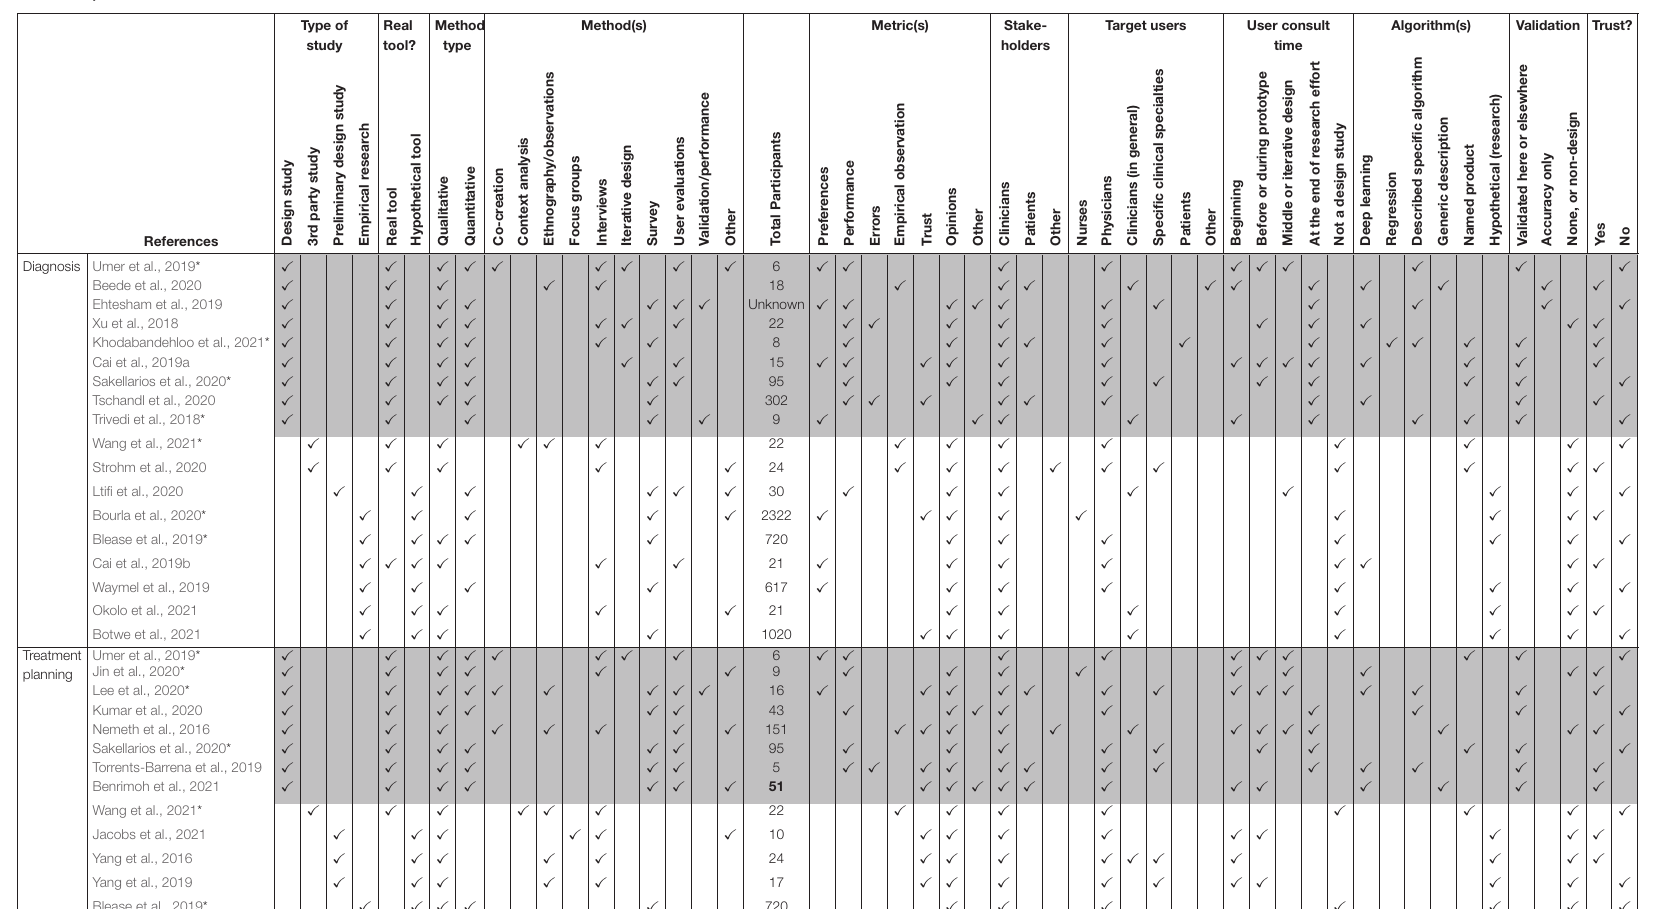
TABLE 3 | Product matrix of clinical AI tool literature